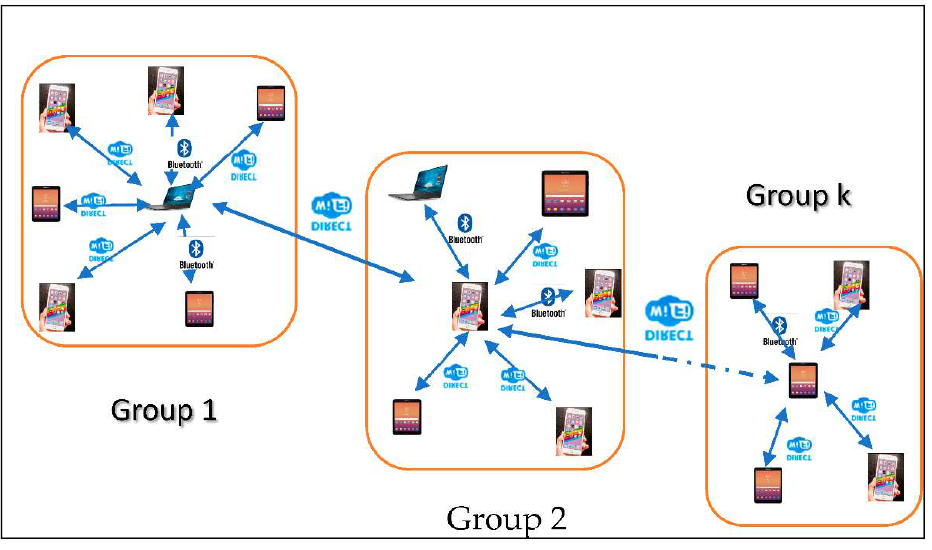
Figure 2. Groups of objects (devices) that communicate by P2P radio connection.